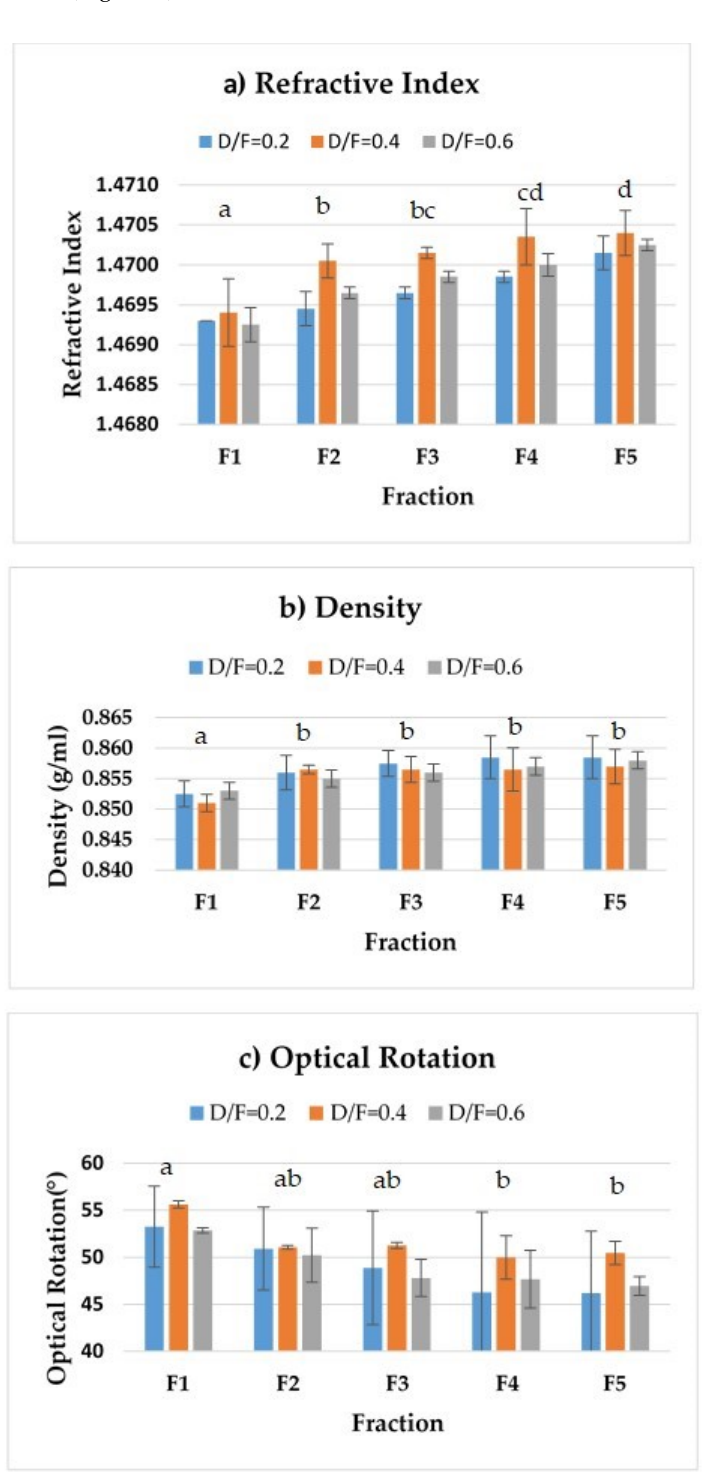
Figure 5. Physical properties: ( a ) refractive index, ( b ) density, and ( c ) optical rotation. The results are the average of three replicates ± standard deviation. Different letters over a column indicate statistical differences (Tukey, p < 0.05)